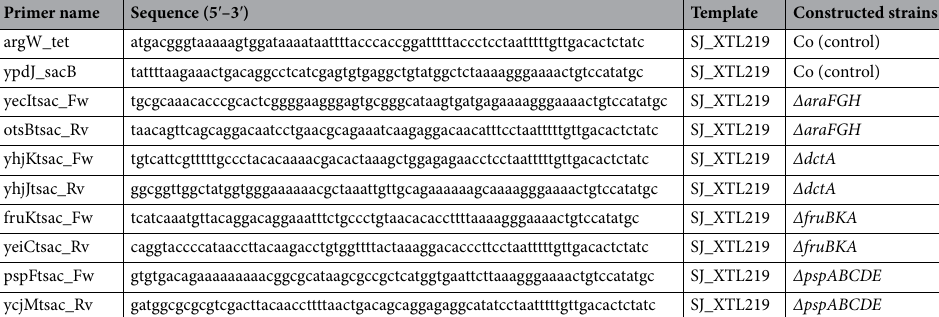
Table 2. Oligonucleotides and templates used for the construction of mutant